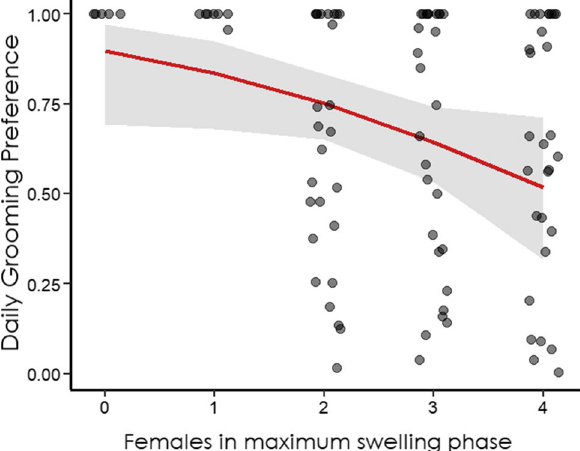
Figure 1. Effect of the number of females in maximum swelling phase on daily grooming preference (red solid line) at the average of all other predictors. Gray band indicates 95% Confidence Intervals. Data points are plotted using jitter function at 0.15 (width) to avoid complete overlapping and improve graph